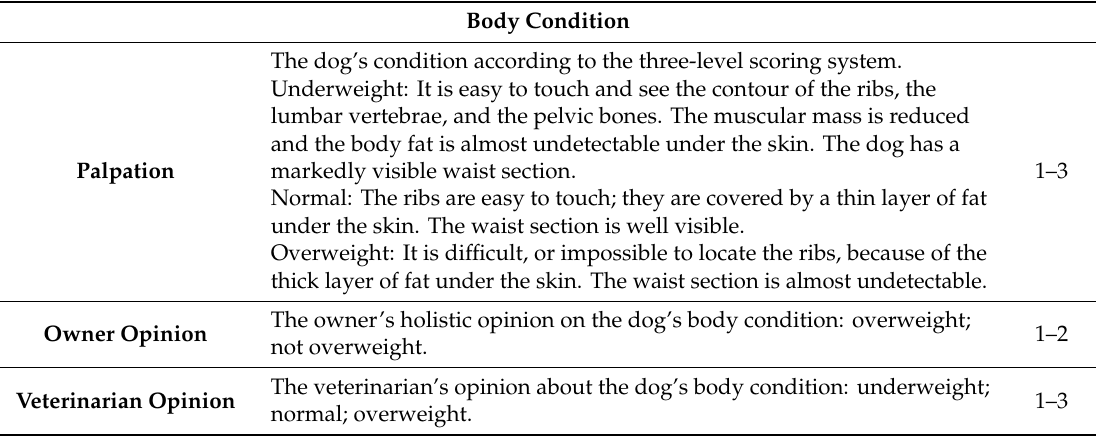
Table 2. The variables used to measure the dog’s body condition (dependent